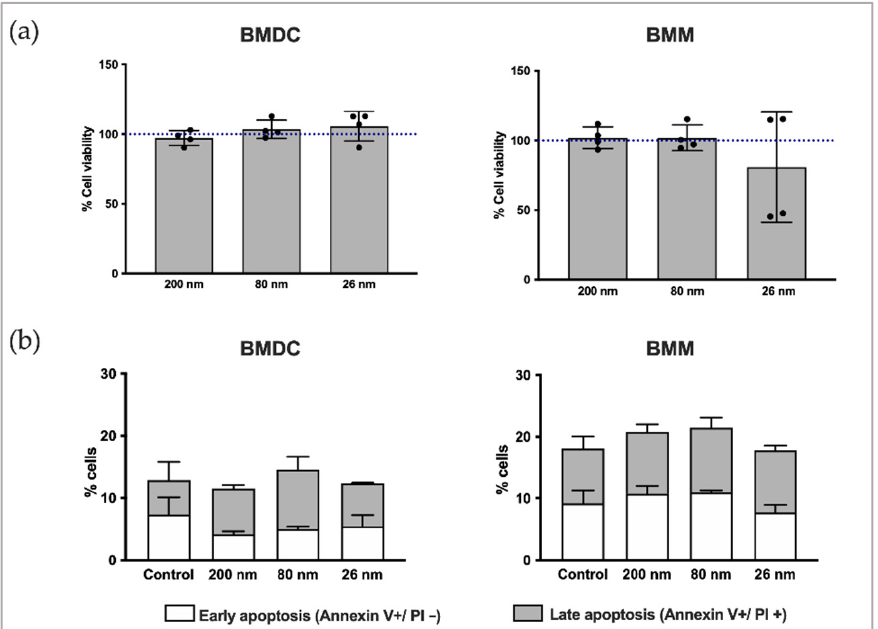
Figure 4. Cell viability of BMDC and BMM treated with β -Glc-PS. BMDC (left) and BMM (right) were stimulated with three different-sized β -Glc-PS for 24 h at a concentration of 10 μ g/mL and analyzed in a ( a ) MTT assay and by ( b ) FITC-annexin V staining, using flow cytometry. Samples were acquired on FACSCantoII (BD Biosciences) and data analyzed with FlowJo software (Version 10.0.7). Each black dot corresponds to the mean value of three technical replicates of an independent experiment.